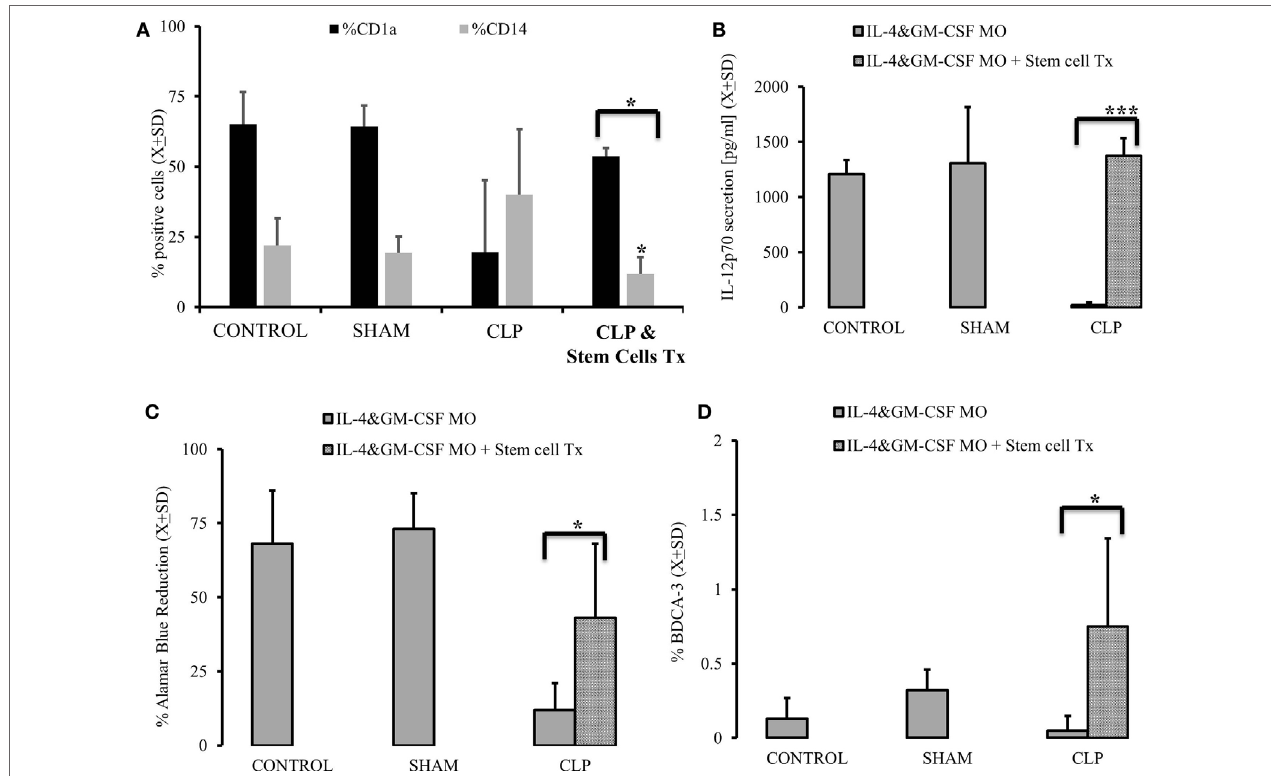
FigUre 5 | autogenous stem cells transplant restores the ability of monocytes (MO) to become dendritic cells (Dcs) in vitro in cecal ligation and puncture (clP) survivors . MO obtained from animals control (CONTR; n = 8), sham-operated (SHAM n = 6), surviving CLP (CLP; n = 14), and CLP survivors receiving 2 × 10 5 autogeneic stem cells (CLP&Tx; n = 7) 2 week after initial CLP. These animals were sacrificed 2 weeks later. Their MO isolated and subjected to IL-4&GM-CSF differentiated conditions using DC marked (CD1a) and MO marker (CD14) (a) . We also measured recovery of the production of IL-12p70 (B) after stem cell transplant vs CLP alone animals. Concomitantly we measured ability of differentiated MO to stimulate T cells in mixed lymphocyte reaction showed as a reduction of Alamar Blue (c) . Recovery of endogenous DBCA( + ) DC was abserved as well (D) . Solid gray bar represent experiment done with cells obtained with CLP alone. Dotted bars represent experiments where 2 × 10 5 autogeneic stem cells were conducted. Bars represent average of results ( X ) with SD. Data were analyzed by t -test for parallel group comparisons (* p < 0.05, ** p < 0.01, *** p <